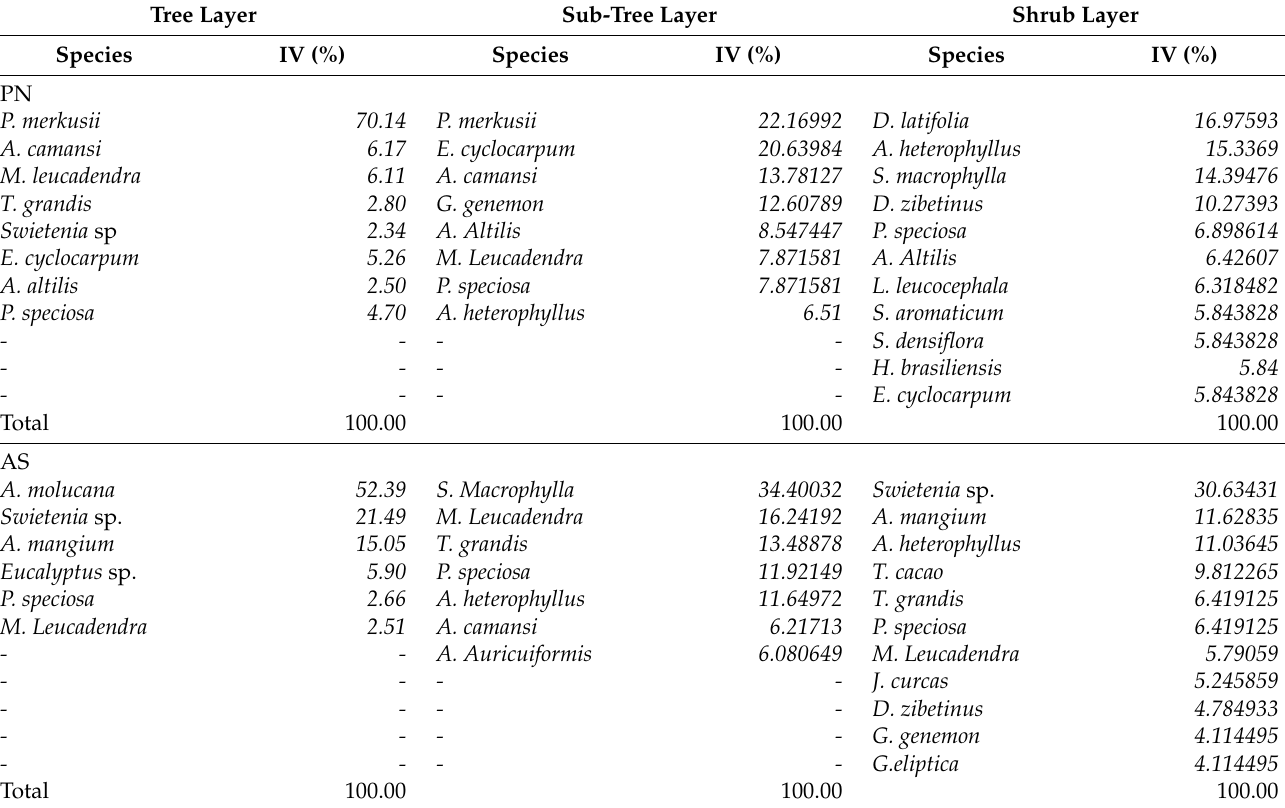
Table A1. Species